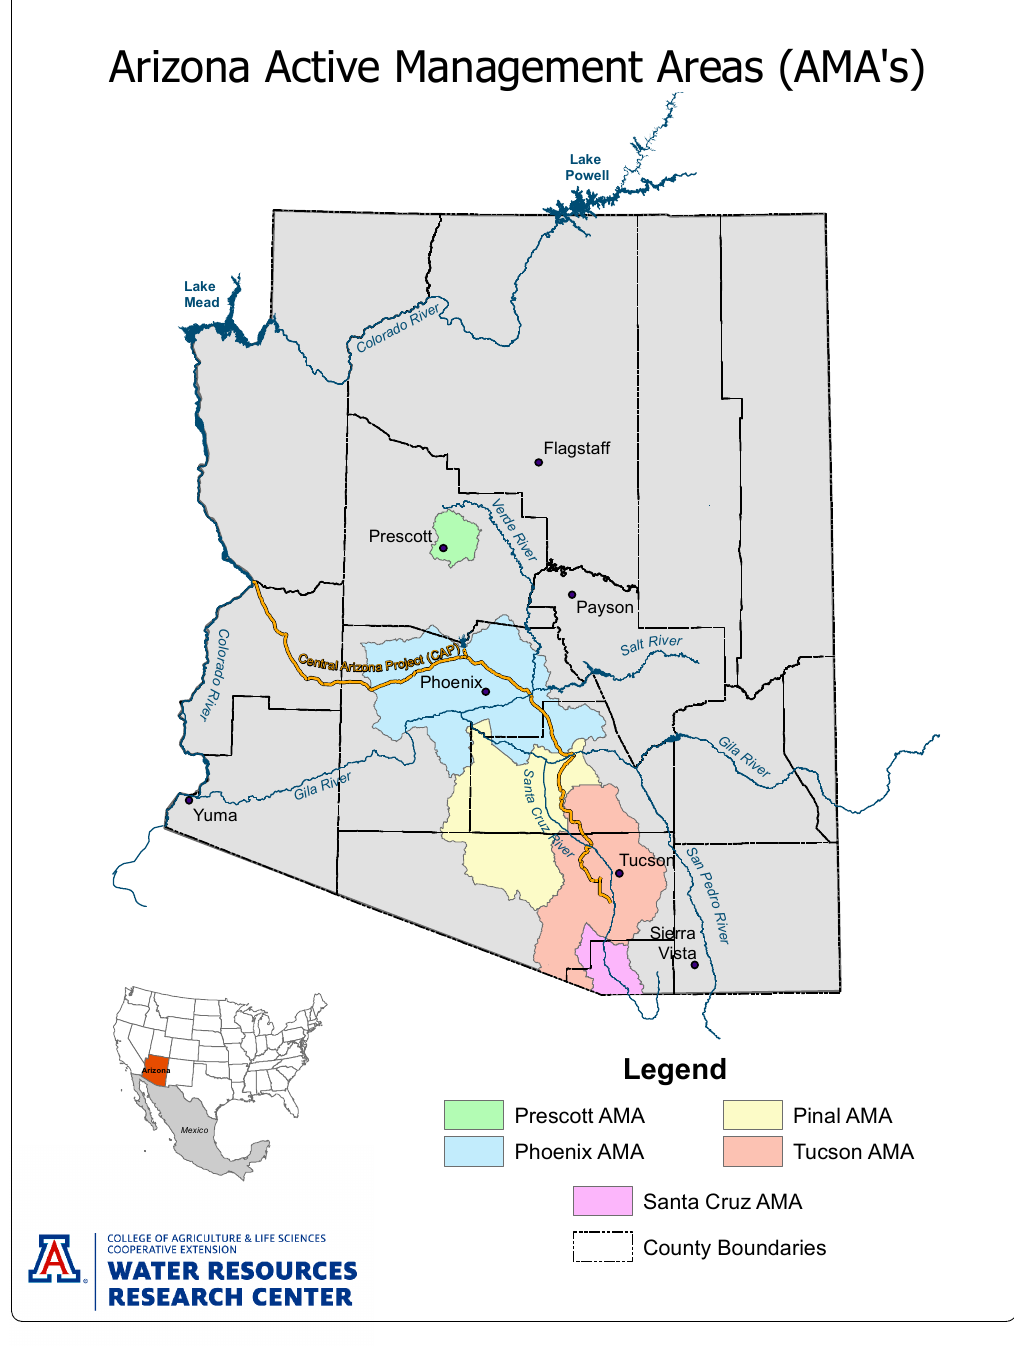
Figure 1. Map of Arizona showing the Active Management Areas and county